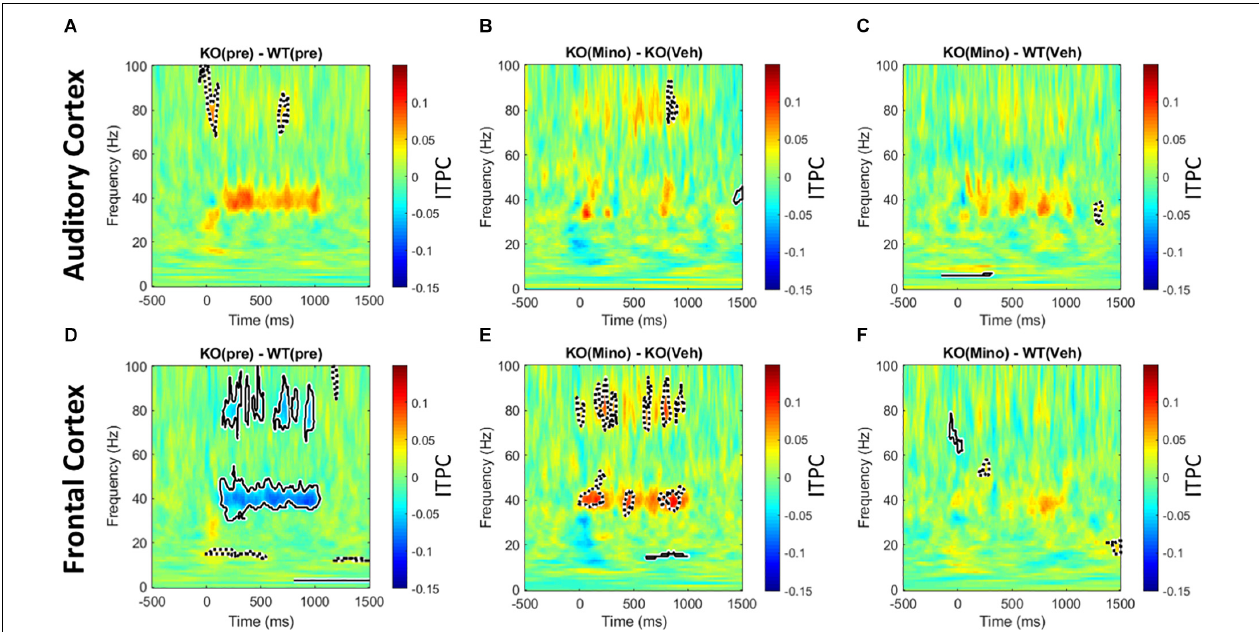
FIGURE 6 | Minocycline reverses phase locking deficits in the 40 Hz ASSR in the FC. An auditory steady state response is the response to a series of 40 Hz train of clicks (1 s duration). The analysis and interpretation are the same as in Figure 5 . Comparing genotype differences in ITPC before drug treatment reveals a robust reduction in the Fmr1 KO mice compared to WT in the FC (D) , but not in the AC (A) . After treating KO mice with minocycline for 10 days, ITPC values in the FC increased significantly compared to vehicle-treated controls in matching time x frequency regions (E) , with no effect in the AC (B) . Direct comparison of ASSR in Fmr1 KO mice treated with minocycline to vehicle-treated WT mice show virtually no difference, suggesting a rescue of the phenotype in the FC (F) , and again no effect found in the AC (C)